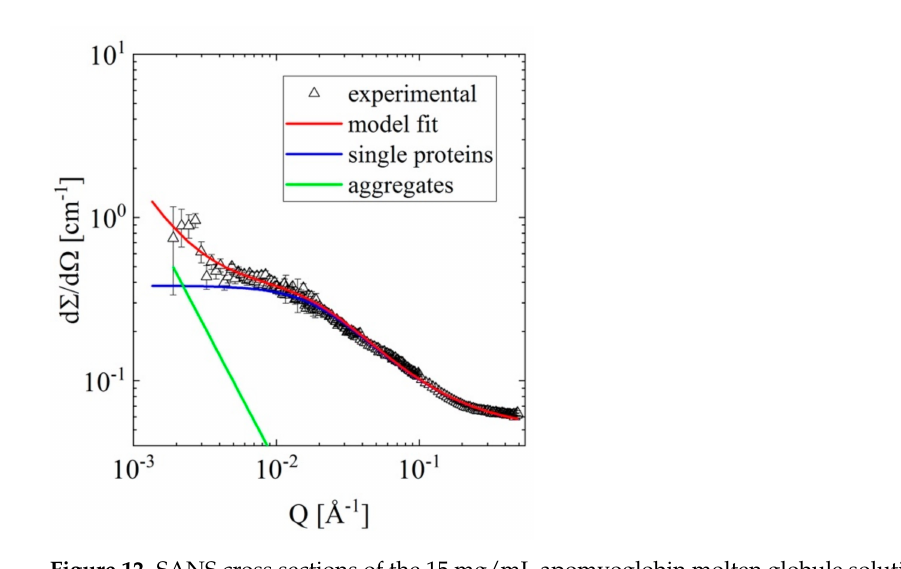
Figure 12. SANS cross sections of the 15 mg/mL apomyoglobin molten globule solution. The blue line marks the simulation for the monomer scattering intensity based on the polymer with excluded volume model (R g = 2.5 nm, ν = 0.46). The green line is the simulated scattering curve for a larger structure. The red line is obtained by adding the green and blue lines and describes the data